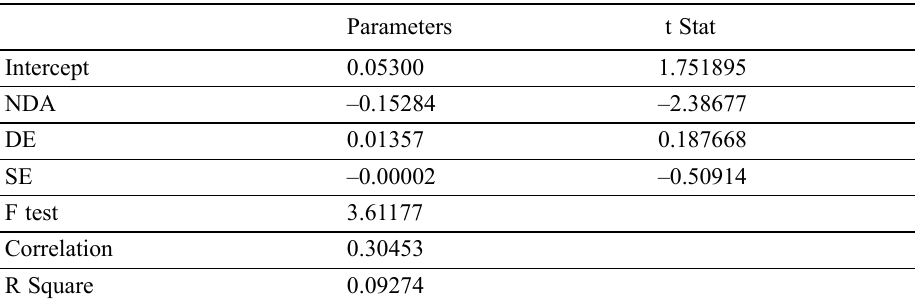
Table 3. Statistical Description of ROA